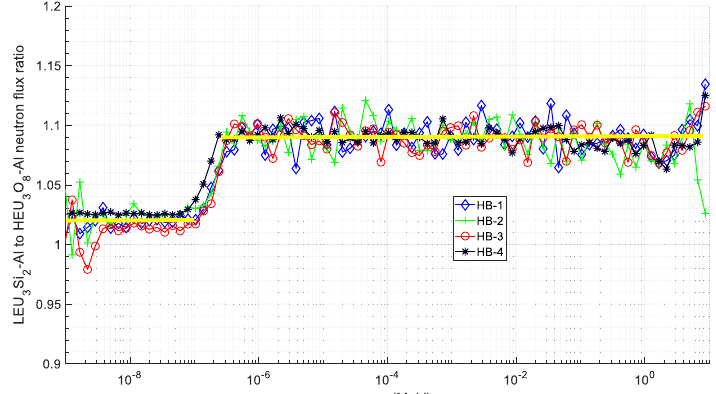
Figure 7. Comparison of end-of-cycle Optimized and HEU horizontal beam (HB) tube